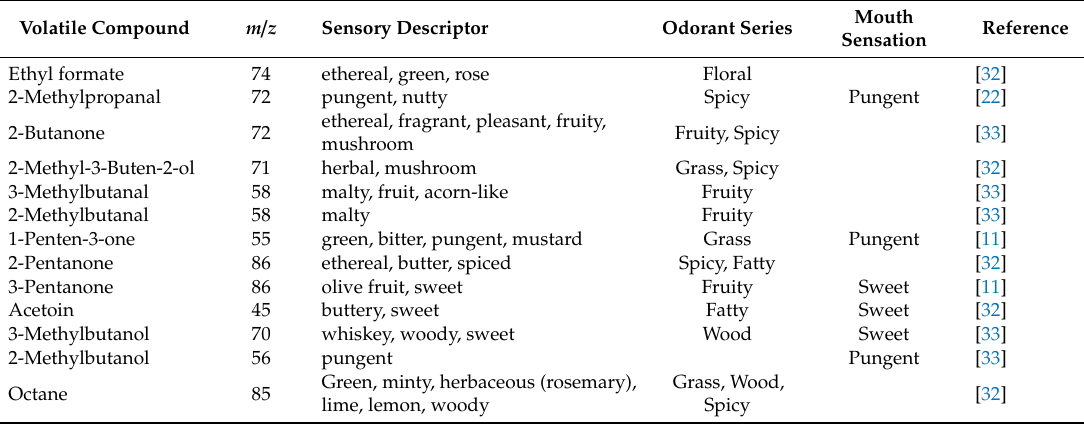
Table 2. Volatile compounds found in studied VOOs and their aromatic